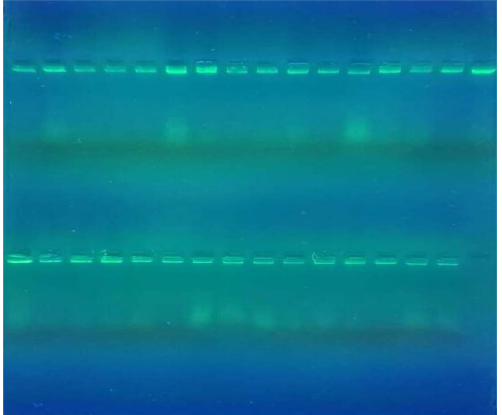
Fig. 2. Gel Electrophoresis of genomic DNA on 1%agarose gel, (70 Volt/30 minute)